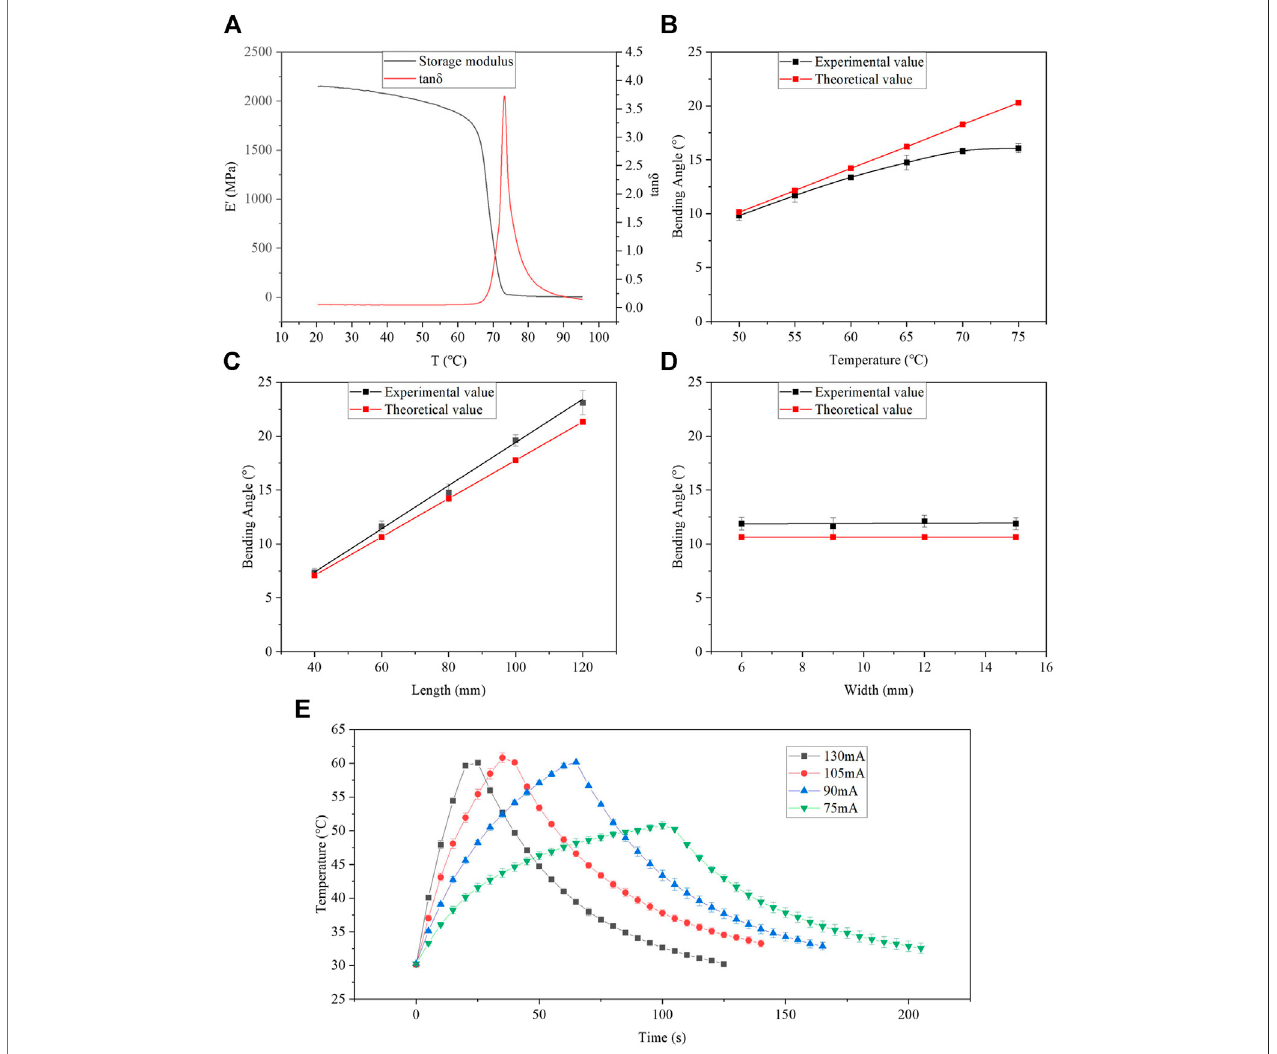
FIGURE 3 | (A) Results of DMA test of matrix material. Characterization of bending angle as a function of (B) actuation temperature, (C) design length, (D) design width. (E) Temperature as a function of time for various actuation currents.